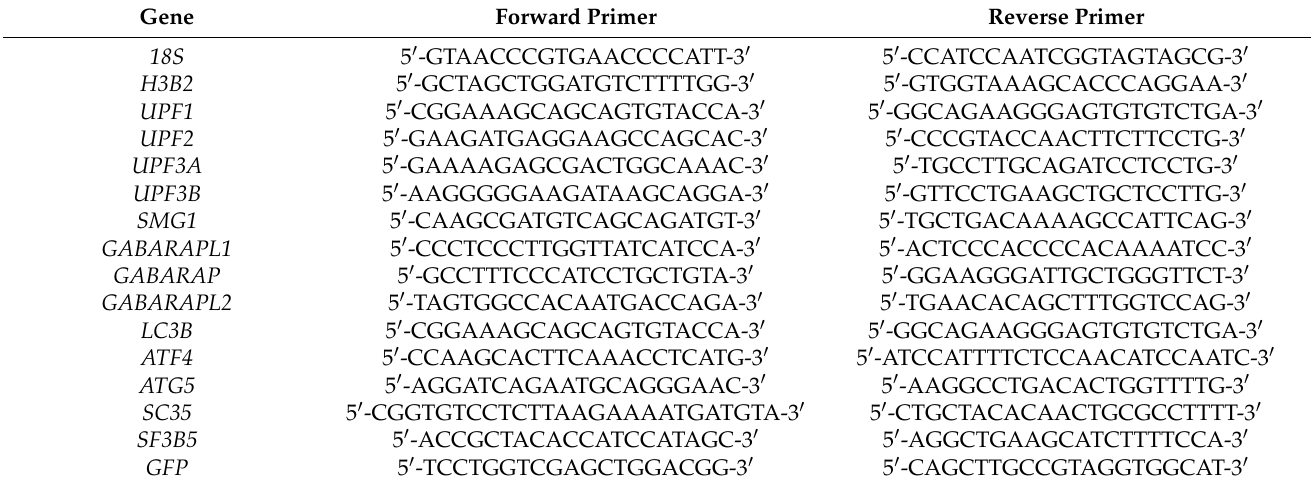
Table 2. Primer sequences used for the SyberGreen RT-qPCR